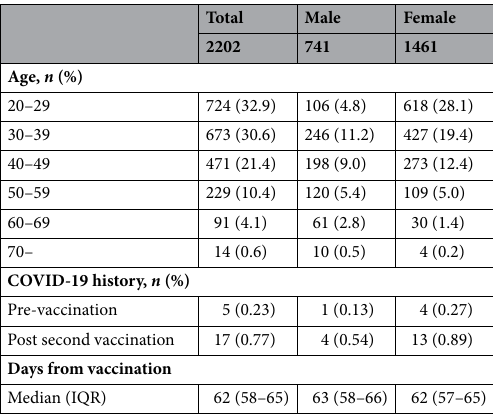
Table 1. Characteristics of healthcare workers in this